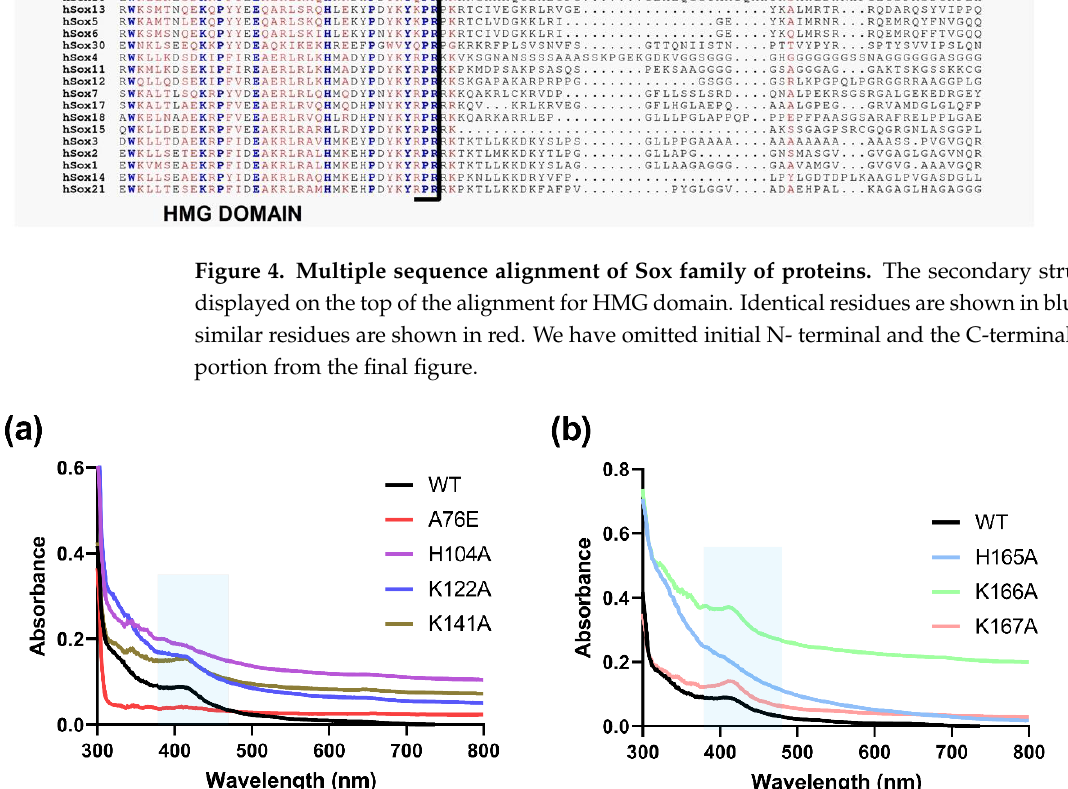
Figure 5. Absorbance spectroscopy of Sox9 and mutants. Absorbance of Sox9HMG-sox_N domain and key site directed mutants showing the loss of peak at ~420 nm for ( a ) A76E and H104A and ( b ) H165A.